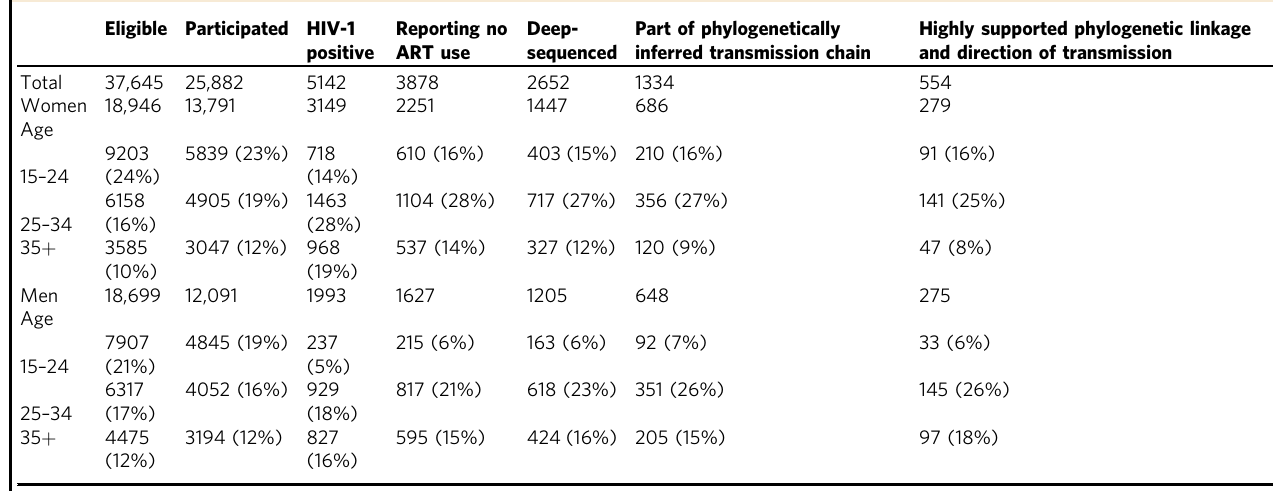
Table 1 Characteristics of the study population Eligible Participated HIV-1